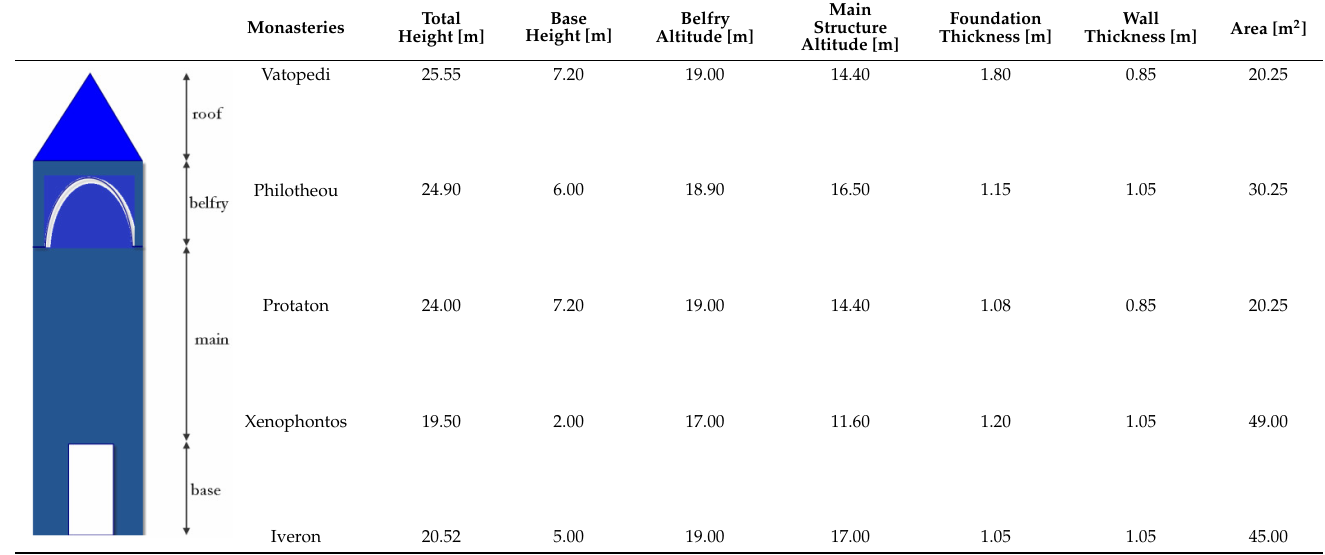
Table 1. Geometrical characteristics of the case-study bell